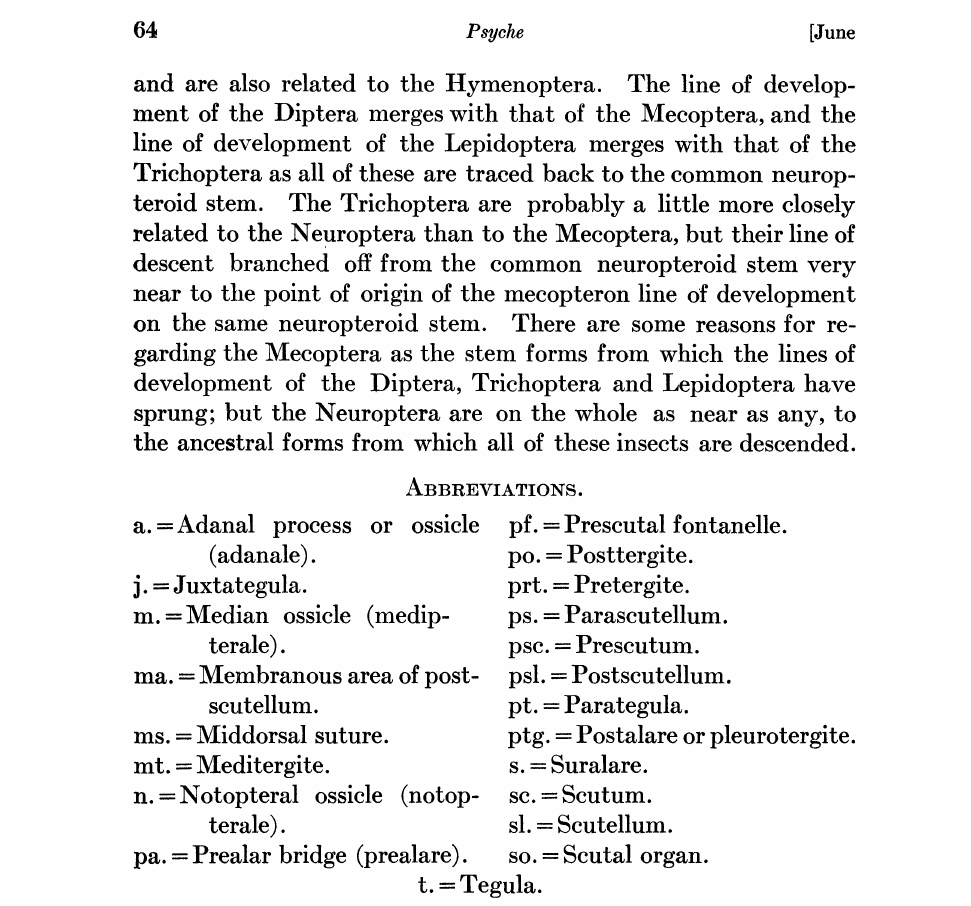
Fig. 3. Fig. 5. Mesonotum and wing-base of the Neuropteron Nemop- tera. Fig. 6. Mesonotum and wing-base of the Dipteron